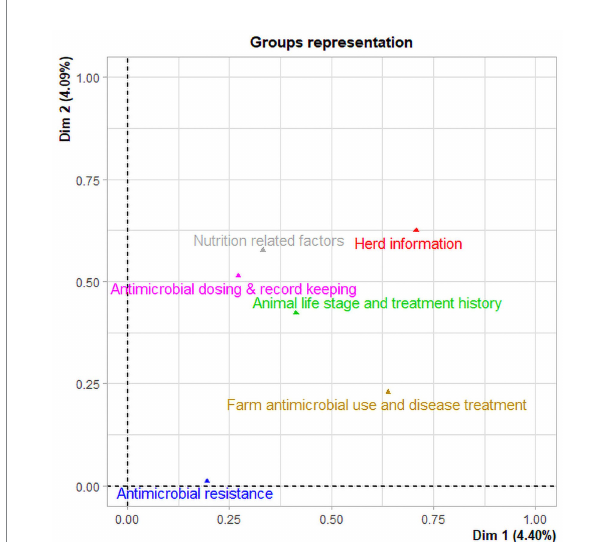
FIGURE 2 Multiple factor analysis of data collected from beef ranches in California in a cross-sectional study evaluating antimicrobial resistance and antimicrobial drug use in 18 cow-calf operations in northern California between July 2019 and August 2020. Two groups (Herd information and Farm antimicrobial use and disease treatment) have the highest coordinates indicating the largest contribution to the first dimension. In the second dimension, the three groups (Nutrition related factors, antimicrobial dosing and record keeping, and sampled Animal life stage and treatment history) have the highest coordinates indicating the largest contribution to the second dimension.